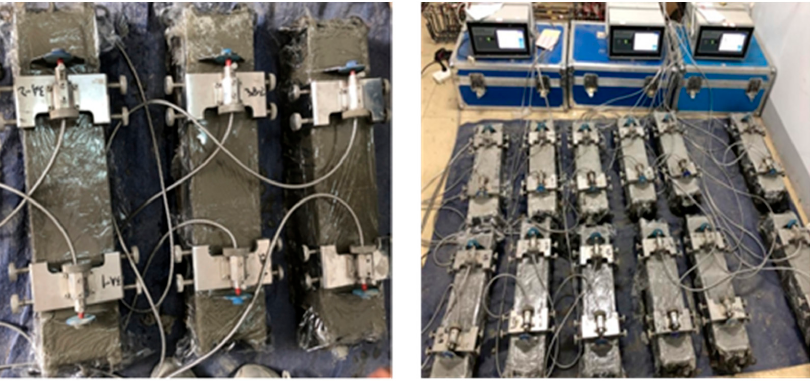
Figure 2. Concrete autogenous shrinkage test.